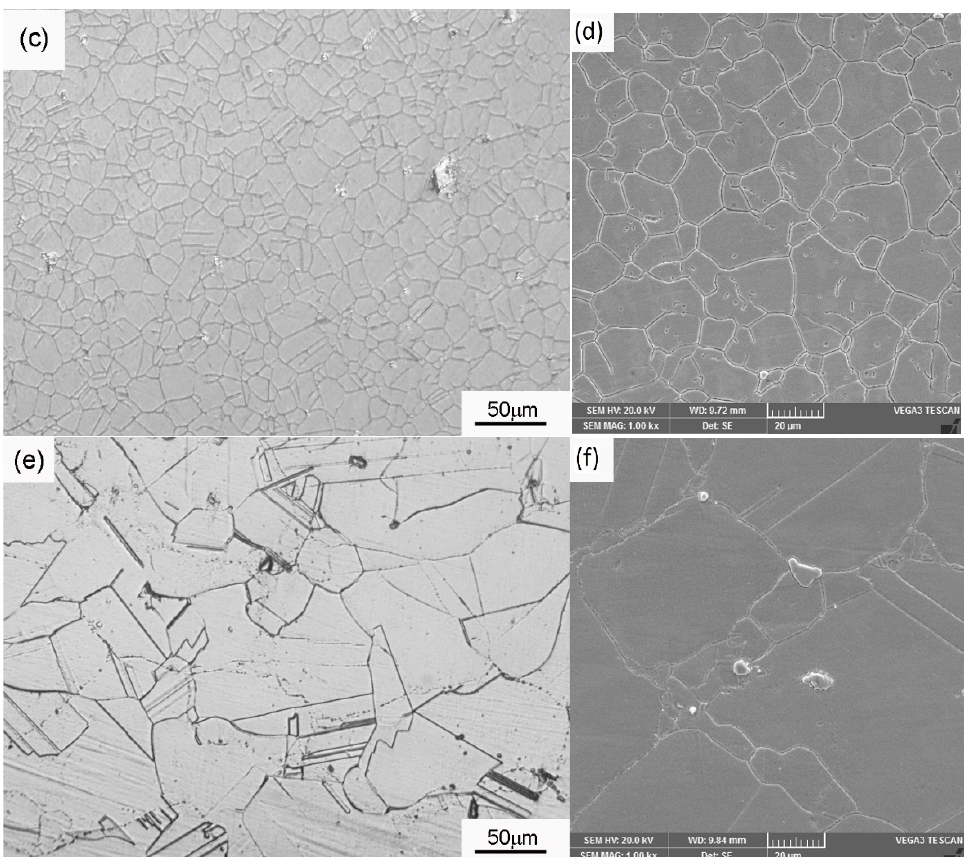
Figure 2. Optical micrograph and secondary electron micrographs of the F22 base metal ( a , b ), 718 base metal ( c , d ), and 625 base metal ( e , f ).